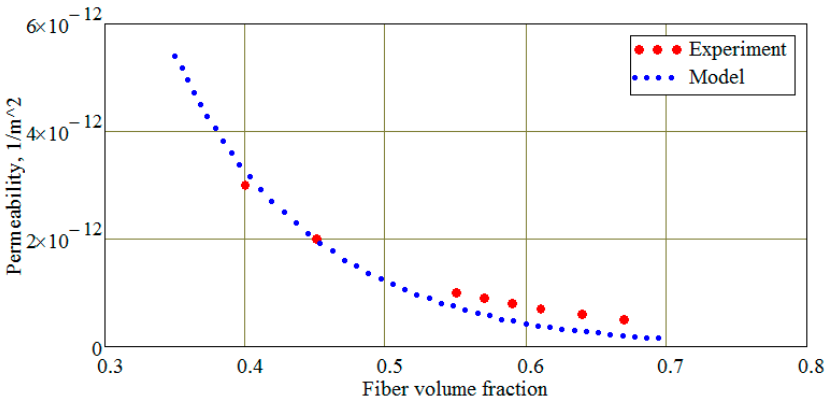
Figure 10. The dependence of the porous medium permeability K on the reinforcement volume fraction V f : experimental data borrowed from the article [6] and their approximation by the model in Equation (11) with the parameter k = 2.41 × 10 − 12 .